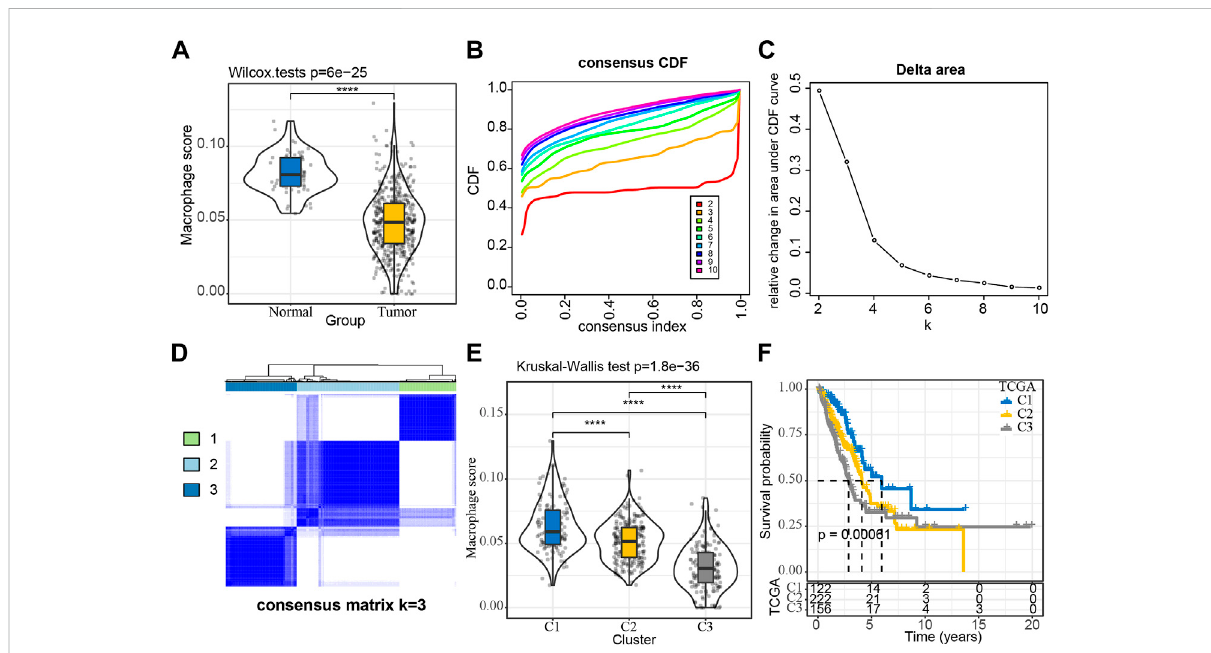
FIGURE 1 Construction of molecular subtypes using macrophage-associated prognostic genes (A) Comparison of Macrophage Score for normal and tumor samples; (B, C) TCGA cohort sample CDF curves and CDF Delta area curves and Delta area curve of consensus clustering, indicating the relativechangeinareaunderthecumulativedistributionfunction(CDF)curveforeachcategorynumber k comparedwith k -1.Thecategorynumber k is represented on the horizontal axis, and the relative change in the area under the CDF curve is shown on the vertical axis; (D) Sample clustering heat map at consensus k = 3; (E) Distribution of Macrophage Score among subtypes; (F) KM curves of the relationship between the prognosis of the three subtypes. **** p <